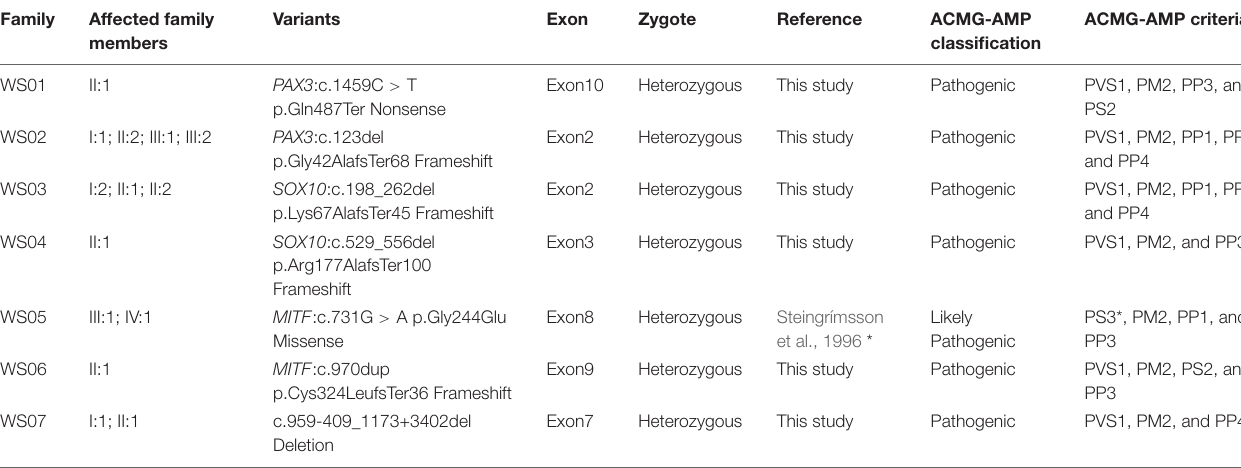
TABLE 3 | Gene variants and pathogenicity analysis of patients.